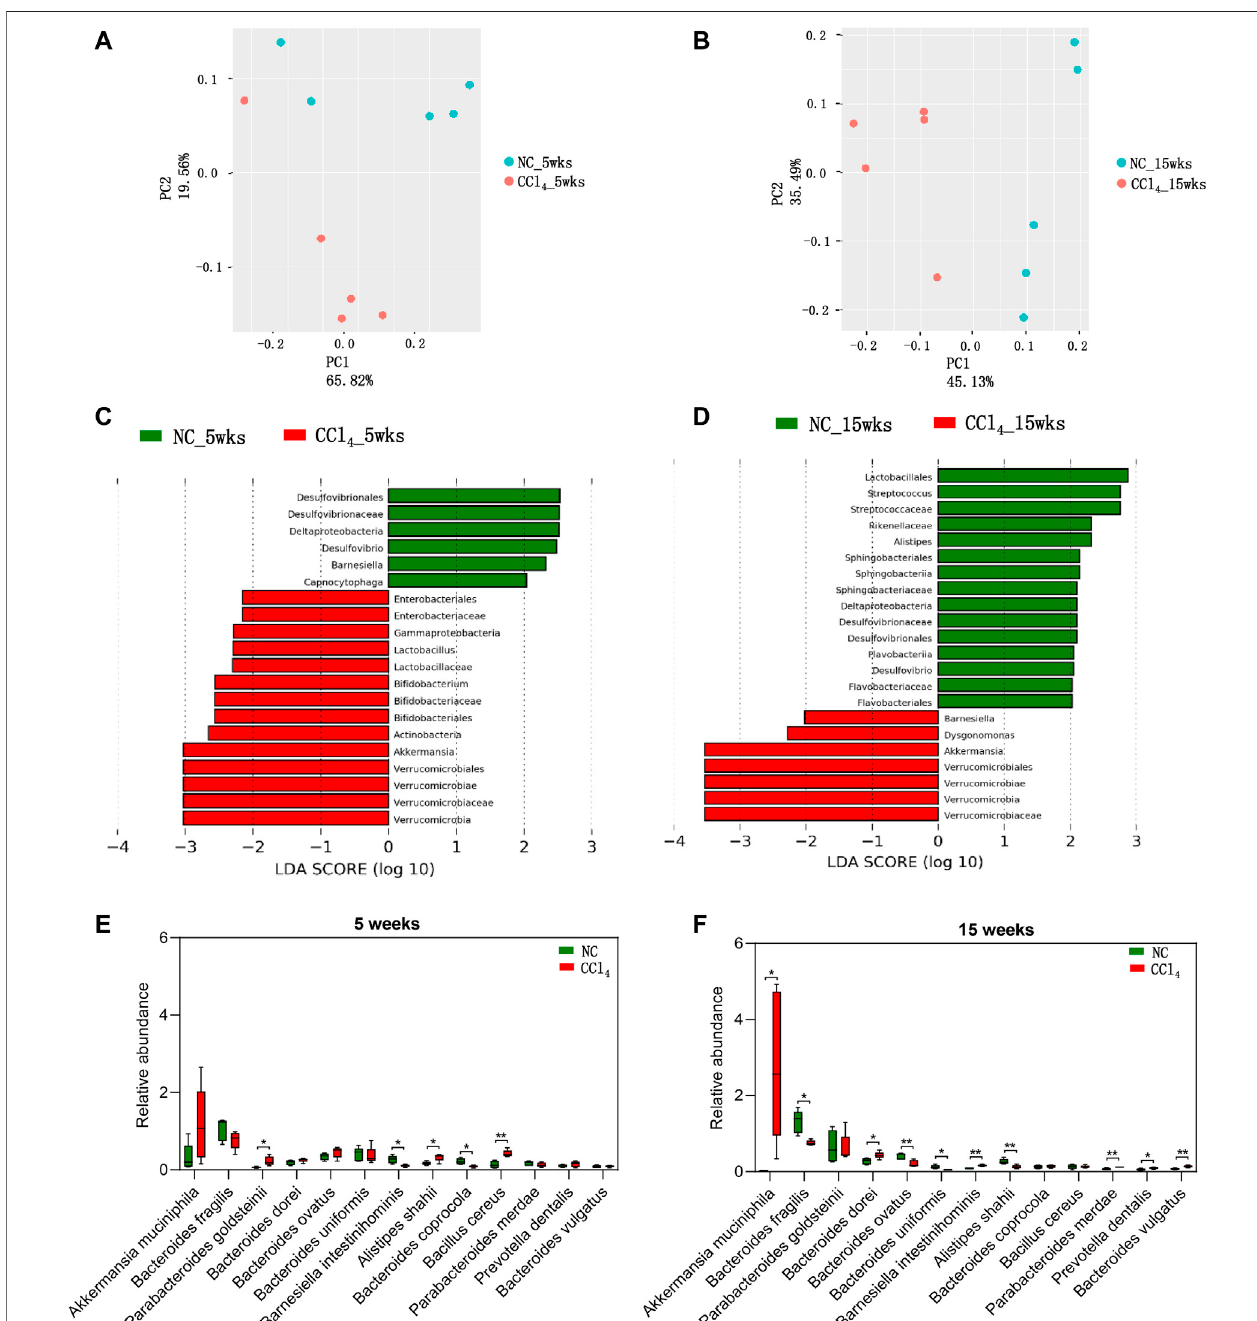
FIGURE 2 | Dynamic alterations of microbial composition in mice during the development of CCl 4 -induced liver cirrhosis. (A, B) The β -diversity of gut microbiota is shown by PCoA plots based on Bray-Curtis dissimilarity. (C, D) LEfSe analysis was performed using the predominant microbiota from phylum, class, order, family, and genus levels. The cladogram represents enriched taxon in the NC group (green) and CCl 4 treatment groups (red) with an LDA score > 2 at 5 weeks or 15 weeks after intervention. (E,F) ThepredominantspecieswerecomparedbetweenNCandCCl 4 -treatedmiceafter5-weeksor15-weeksintervention.Note:Dataweregivenas medians with range. n: (A – F) 5 per group. * p < 0.05; ** p < 0.01. Abbreviations: NC, normal control; CCl 4 , carbon tetrachloride; PCoA, principal co-ordinates analysis; LEfSe, Linear discriminant analysis Effect Size; LDA, linear discriminant analysis.